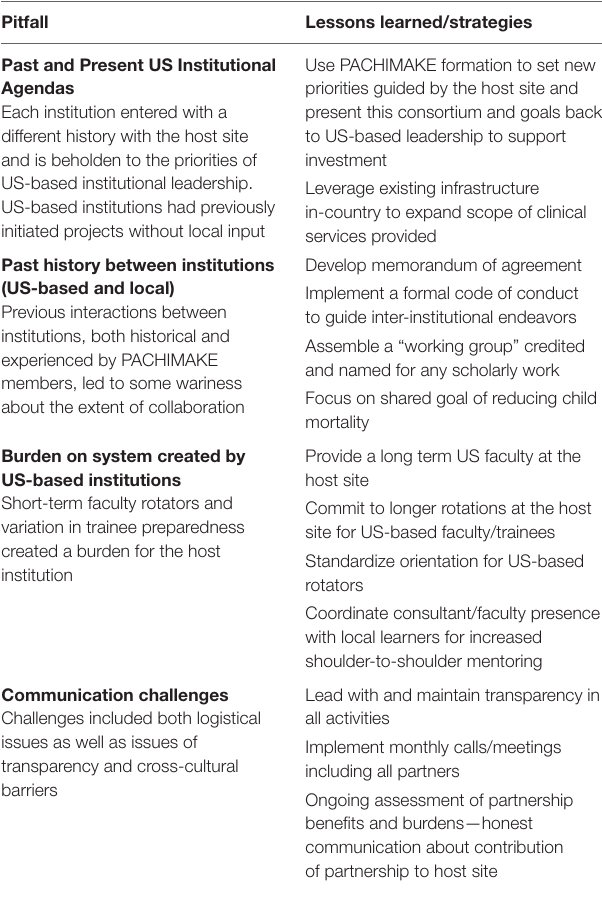
taBLe 2 | Pitfalls and lessons learned/strategies for partnership development.